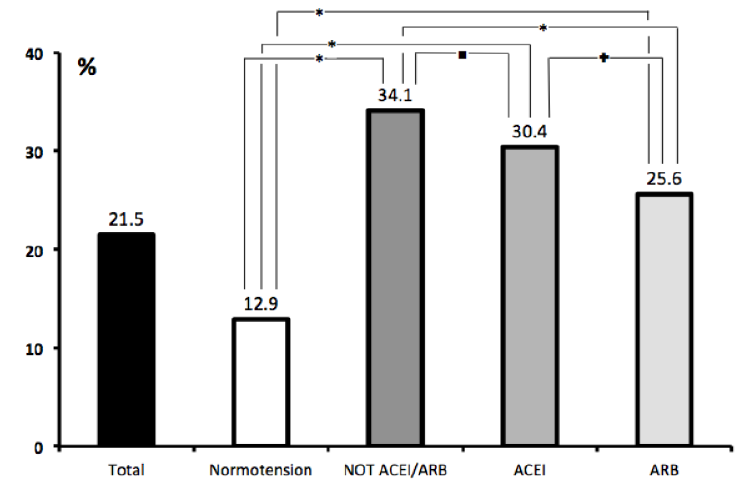
Figure 2. All-cause Mortality according to Hypertension status and previous antihypertensive